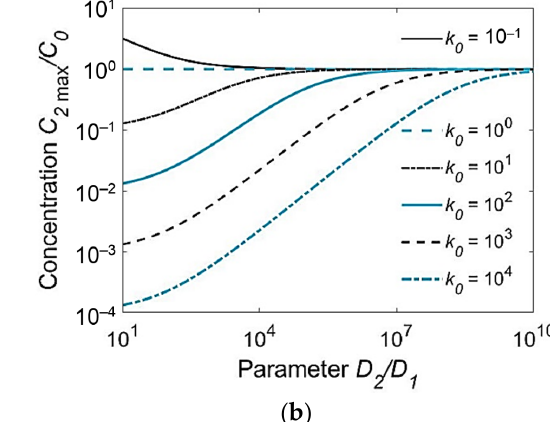
Figure 4. Peak hydrogen concentration in the HAZ at the weld interface ( C 2max ( h 1 ))/ C 0 as a function of the ratio D 2 / D 1 of the diffusion coefficients and the partition coefficient k 0 : ( a ) C 02 / C 01 = 0.1; ( b ) C 02 / C 01 = 1.